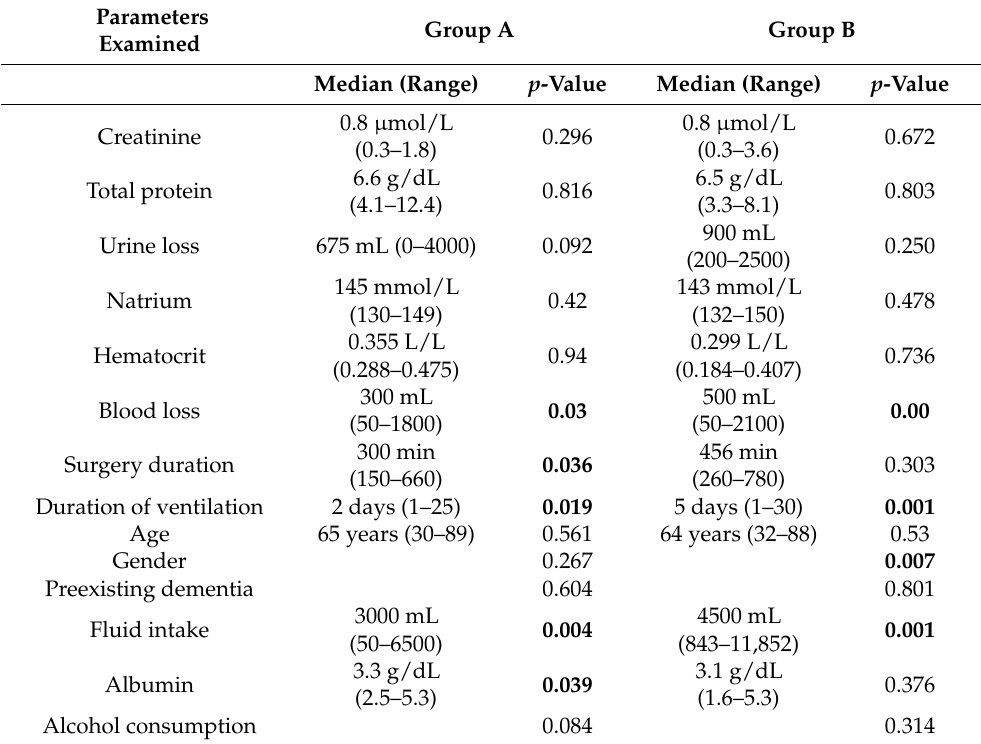
Table 2. Co-variables and p -values in the univariate analysis for groups A and B.